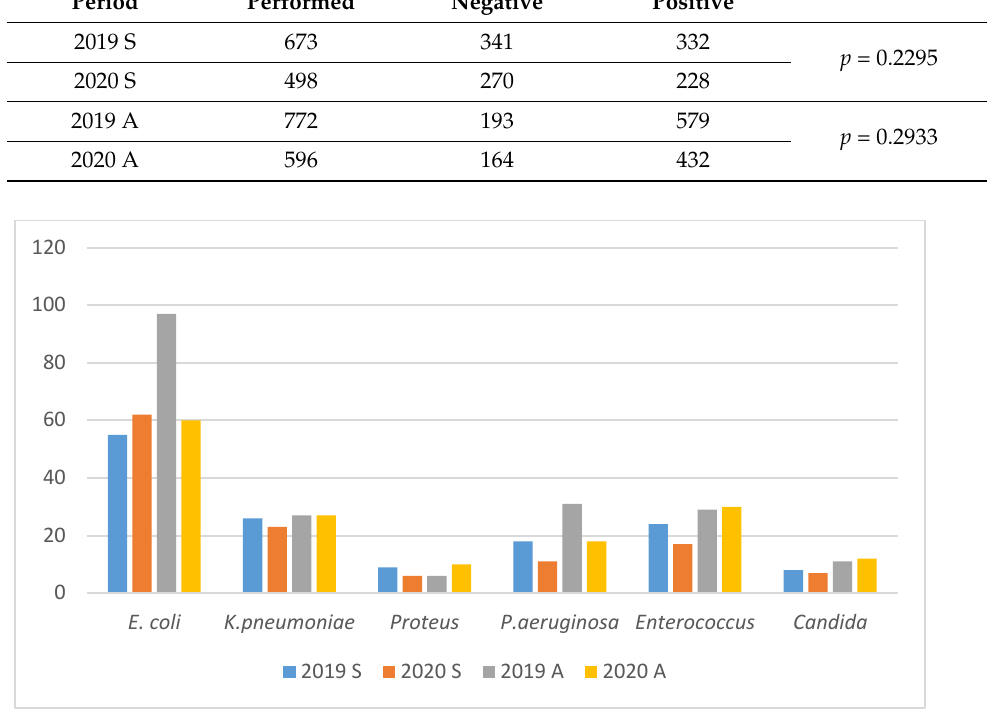
Figure 4. Pathogens found in urine cultures. Table 3. Urine cultures. Table 4. Pathogens found in urine cultures.